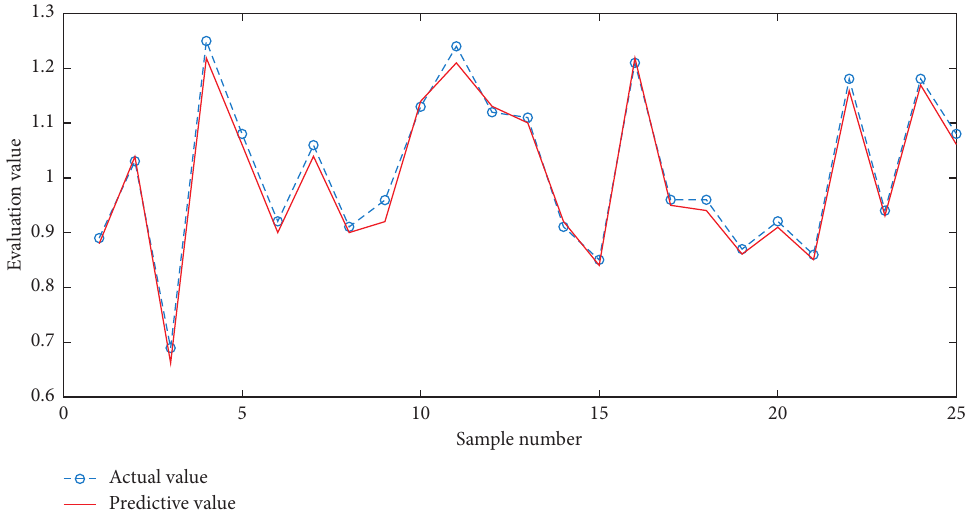
Figure 6: Comparison between the result of the fuzzy theory test knot and the real value.